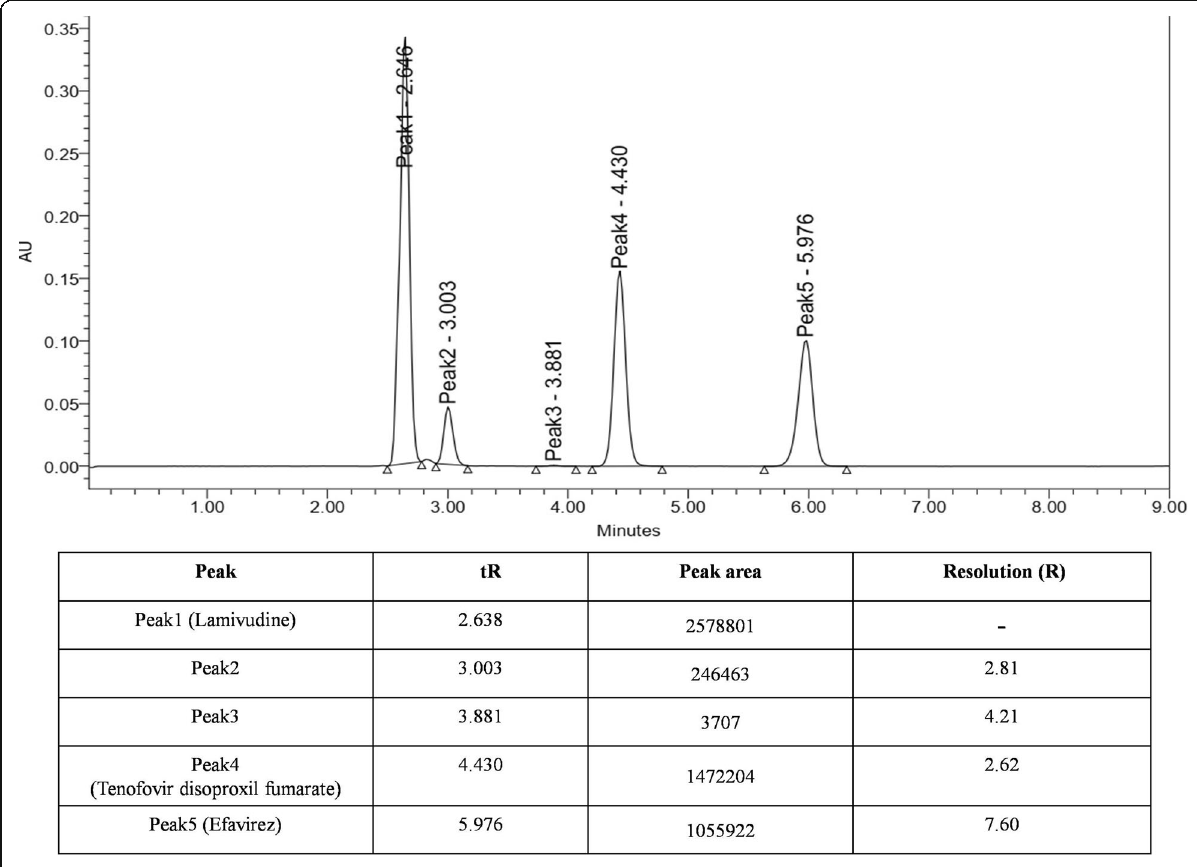
Fig. 5 Chromatogram of base